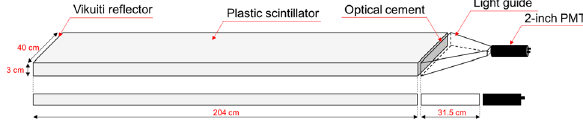
Fig. 7 A schematic view of a muon detector